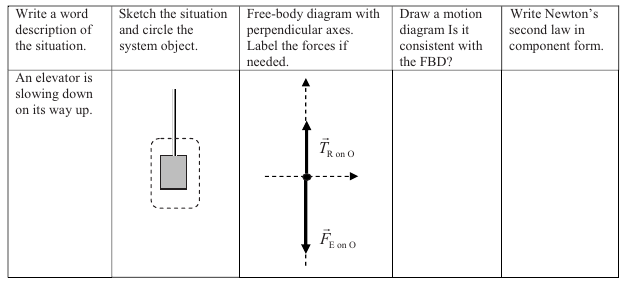
FIG. 5. Example of multiple